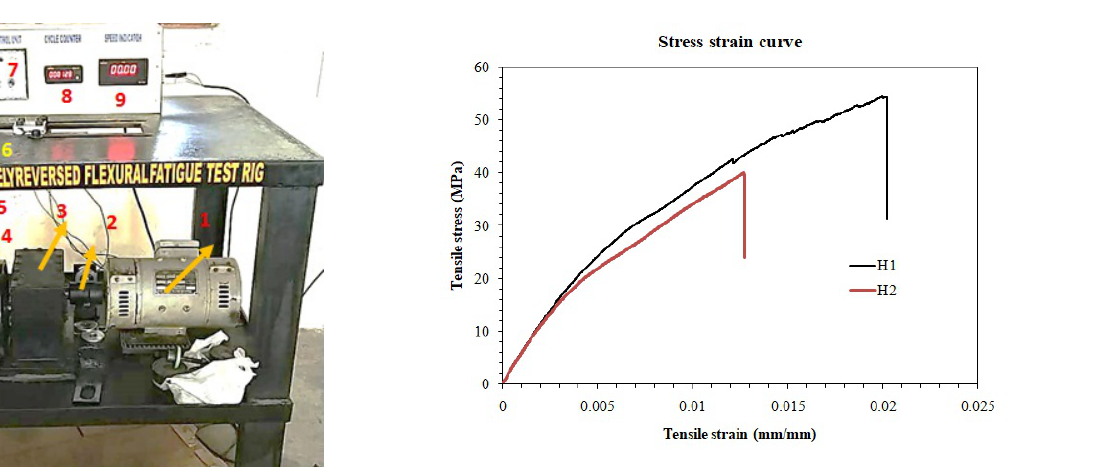
Fig. 8. Comparison of stress-strain plots of glass/jute hybrid laminates.